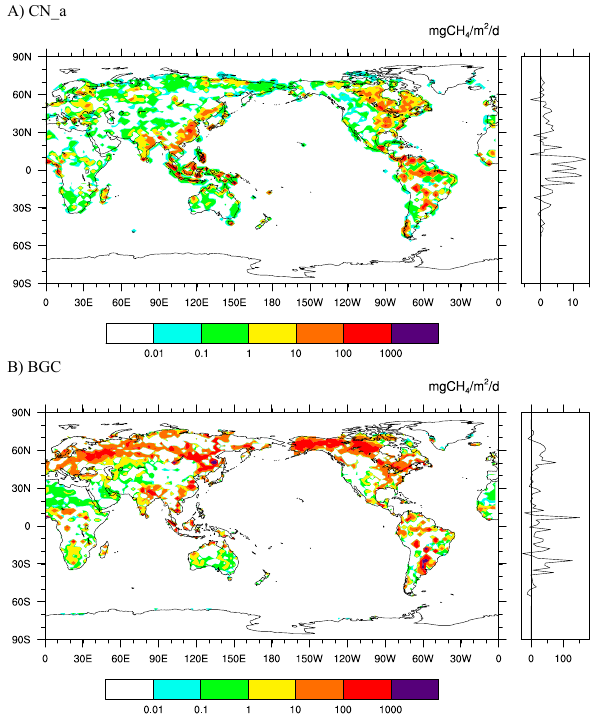
Figure 6. The spatial difference in CH 4 fluxes between four high and low emission years. Please note CH 4 fluxes are plotted on a logarithmic color scale in CN_a (top, a ) and BGC (bottom, b ). The latitudinal average CH 4 flux is plotted on the right.